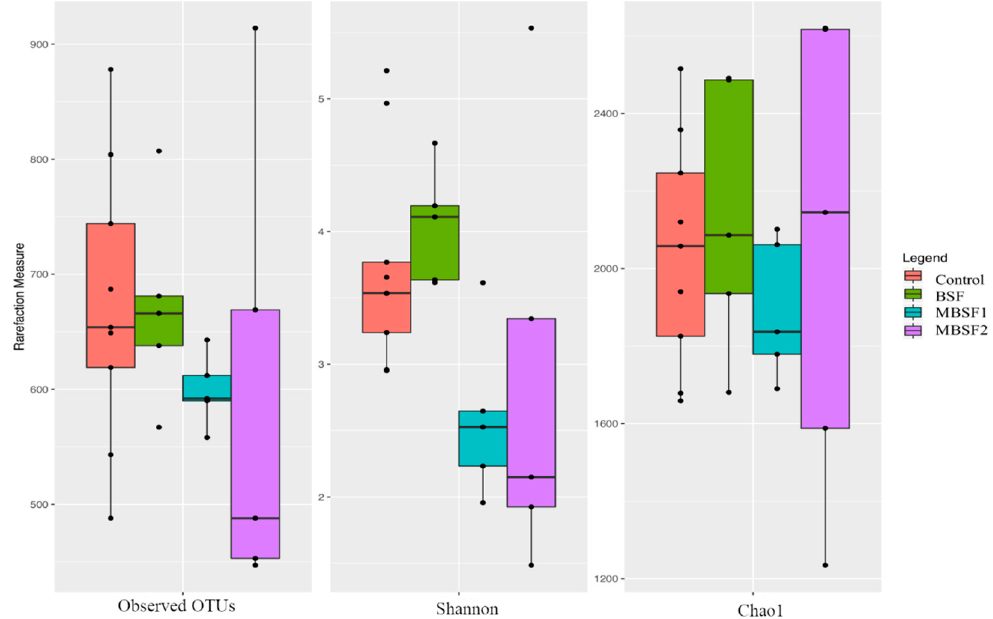
Figure 2. Boxplots to describe α -diversity measures of fecal microbiota of broiler chickens at the end of the experimental trial. BSF = diet with black soldier fly larvae fat; MBSF1 = diet with modified black soldier fly larvae fat type 1; MBSF2 = diet with modified black soldier fly larvae fat type